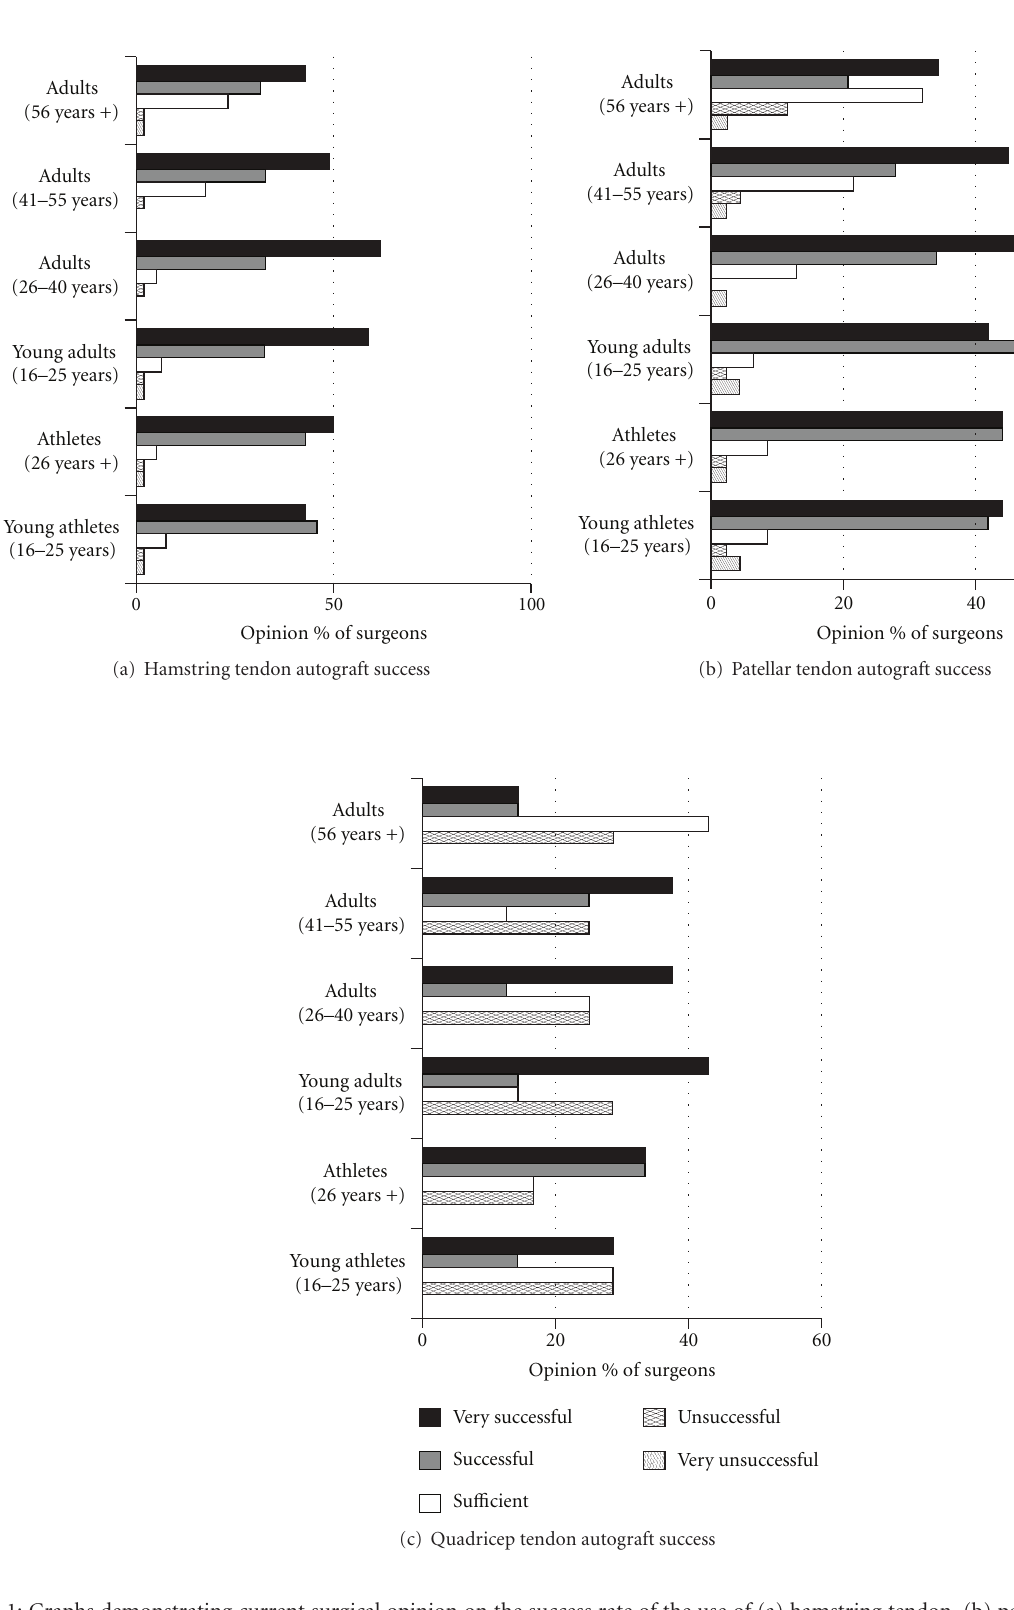
Figure 1: Graphs demonstrating current surgical opinion on the success rate of the use of (a) hamstring tendon, (b) patellar tendon, and (c) quadriceps tendon for the repair of anterior cruciate ligament